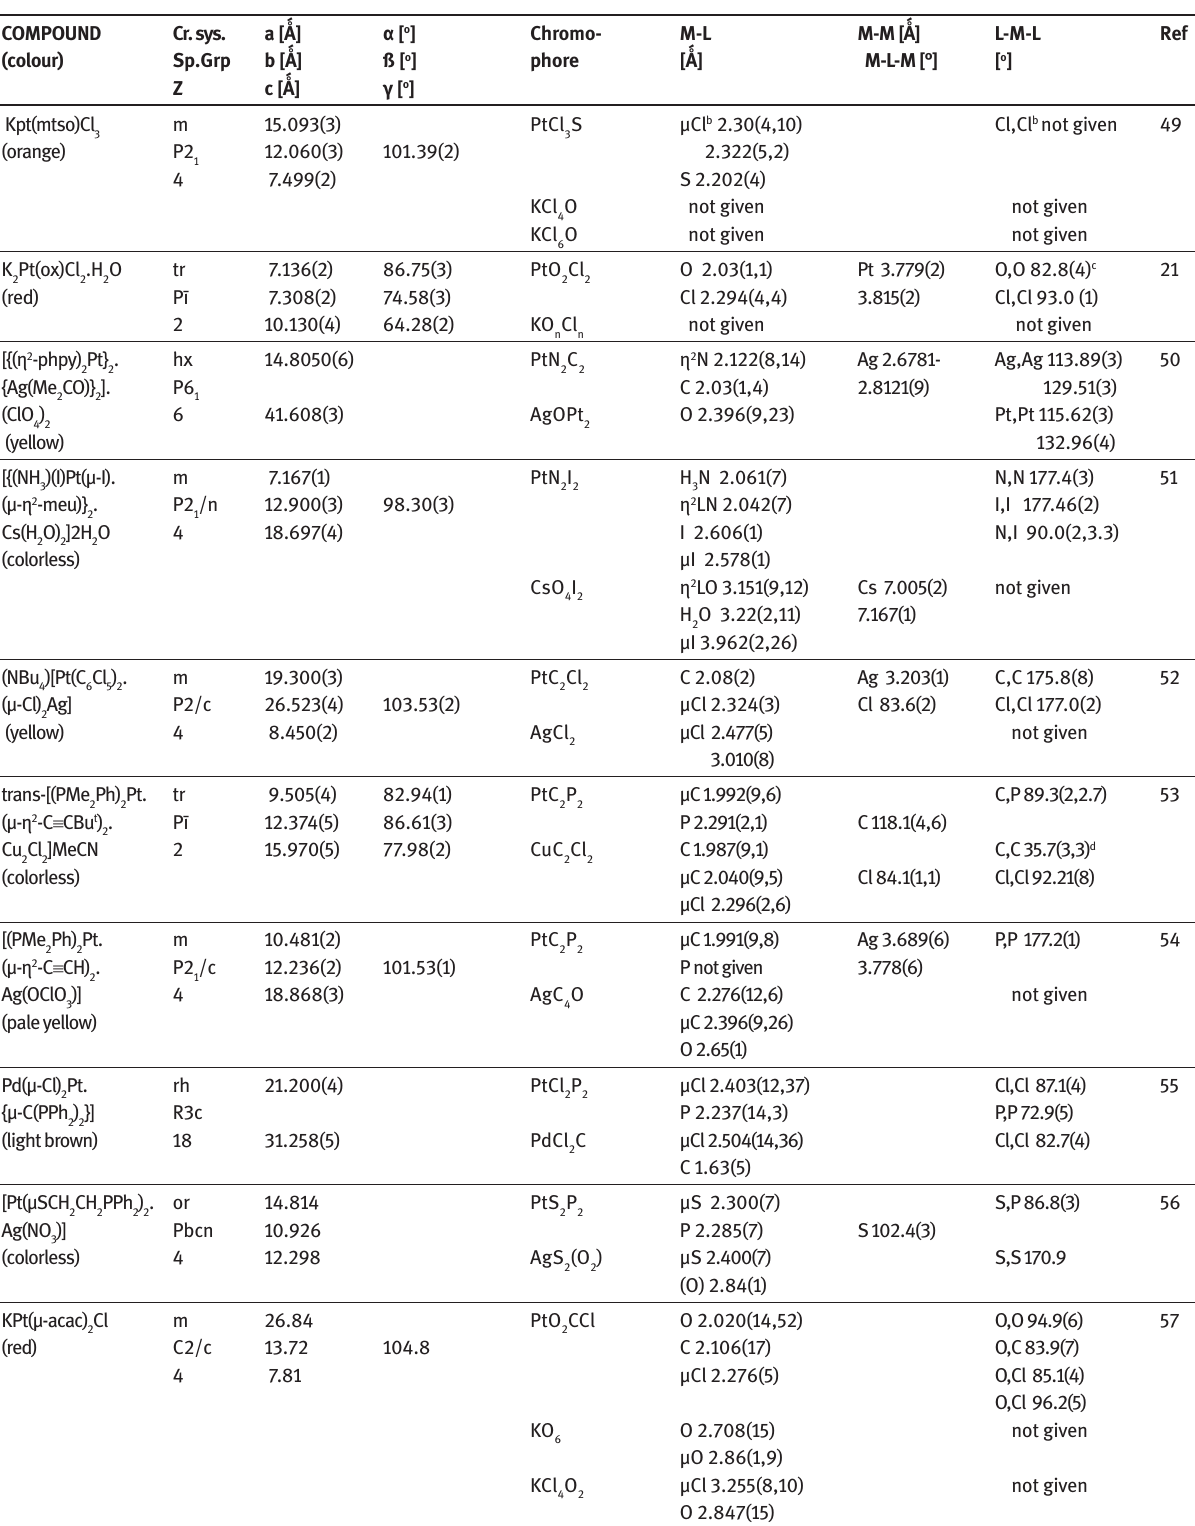
Table 3: Crystallographic and structural data for heteropolynuclear platinum complexes with heterogeneous coordination spheres about Pt a . COMPOUND Cr. (colour)